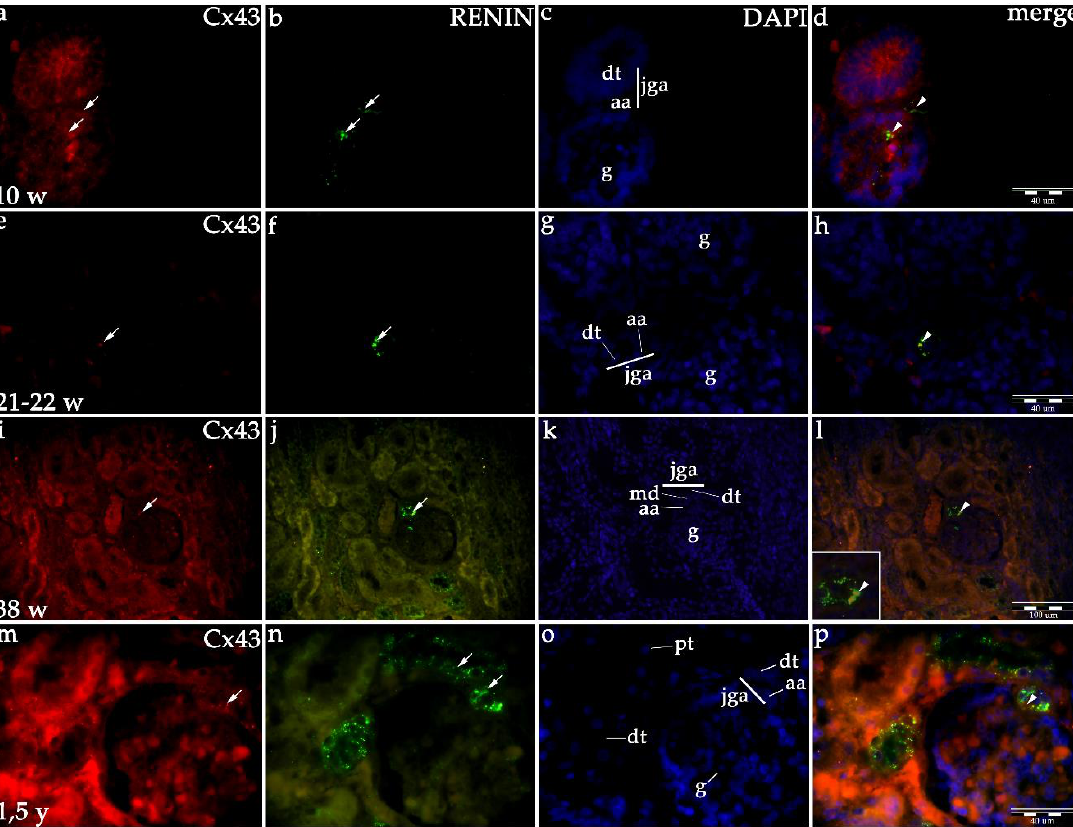
Figure 3. Co-expression of Cx43 and renin in the JGA region of developing and healthy postnatal human kidneys: kidneys in the 8th developmental week ( a – d ); kidneys in the 21–22th developmental week ( e – h ); kidneys in the 38th developmental week ( i – l ), healthy postnatal human kidneys ( m–p ). Glomeruli (g), afferent arteriole (aa), macula densa (md), juxtaglomerular apparatus (jga), proximal tubule (pt), distal tubule (dt). Cxs or renin expression (arrows), DAPI nuclear stain ( c , g , k , o ). Merged microphotographs of different Cxs with renin (merge) show their co-expression (arrowheads) in the jga ( d , h , l , p ). Double immunofluorescence staining of DAPI nuclear stain with Cx43/renin, magnification ×40, scale bar 100 μm ( l ), ×100, scale bar 40 μm ( d , h , p ).